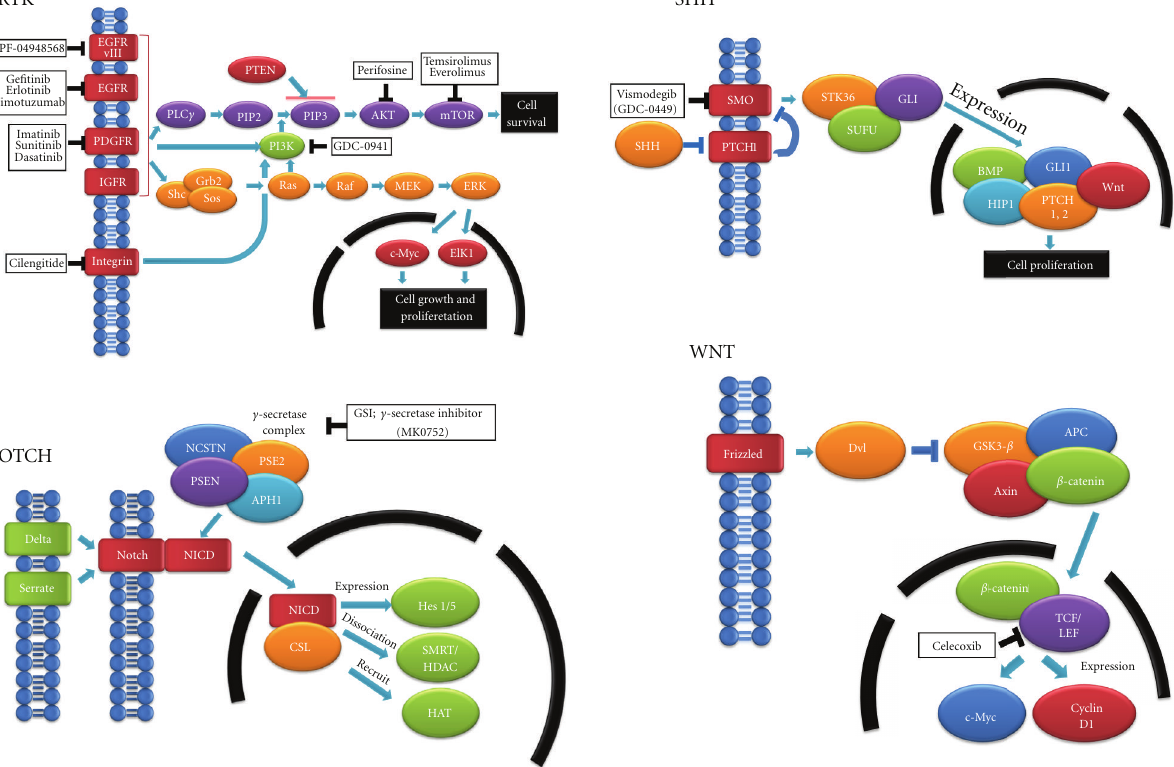
Figure 4: Altered signaling pathways and inhibitors. Receptor tyrosine kinase (RTK), EGFR and platelet-derived growth factor receptor (PDGFR) are receptor tyrosine kinases (RTKs). In GBM, 40–60% of cases exhibit EGFR amplification and high EGFR protein expression levels. PDGFR is overexpressed at the transcriptional level. EGFR activation initiates signal transduction such as the PI3K/Akt pathway. EGFR variant III (EGFRvIII) is a constitutively activated mutation of EGFR , that is, expressed in approximately 25% of GBM cases but not in normal tissues; Sonic Hedgehog (SHH), SHH is a secreted protein critical for pattern formation in the central nervous system. SHH ligand binding to its receptors, patched homolog (PTCH) and smoothened homolog (SMO), leads to the activation of gliotactin (GLI) transcription factors that are translocated into the nuclease to regulate various cellular activities, including the maintenance of cell stemness, survival, and proliferation; NOTCH, The Notch pathway is initiated by the binding of transmembrane ligands on one cell to the notch receptors on an adjacent cell. This binding causes the γ -secretase-mediated proteolytic release of the Notch intracellular domain (NICD). Released NICD translocates into the nucleus and then turns CSL (a transcriptional factor) from a repressor to an activator, causing various e ff ects; WNT, Wnt signals are divided into 2 di ff erent pathways: the canonical or WNT/ β -catenin pathway is involved in cell fate determination and the noncanonical pathway is involved in the control of cell movement and tissue polarity [35]. Following the binding of Wnt protein to a receptor complex comprising Frizzleds/low-density lipoprotein receptor-related protein (Fz/LRP), cytoplasmic disheveled (Dvl) is phosphorylated. The phosphorylation of Dvl inhibits the activity of glycogen synthase kinase-3 β (GSK-3 β ), elevating nonphosphorylated β -catenin levels in the cytoplasm. β -Catenin translocates into the nucleus and forms a complex with members of the T-cell transcription factor (TCF)/lymphoid enhancer-binding factor (LEF) family of transcription